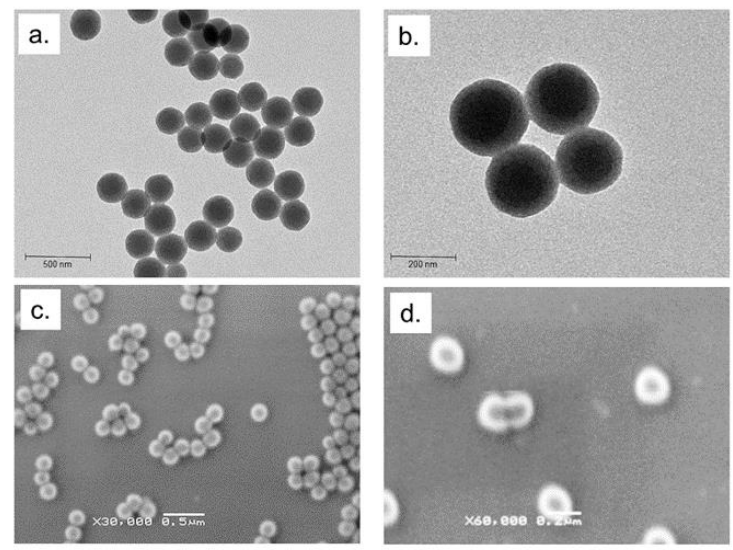
Figure 1. ( a , b ) Representative TEM images (acquired in bright field) and ( c , d ) SEM images of SiO 2 @LA NPs (acquired by secondary electrons).